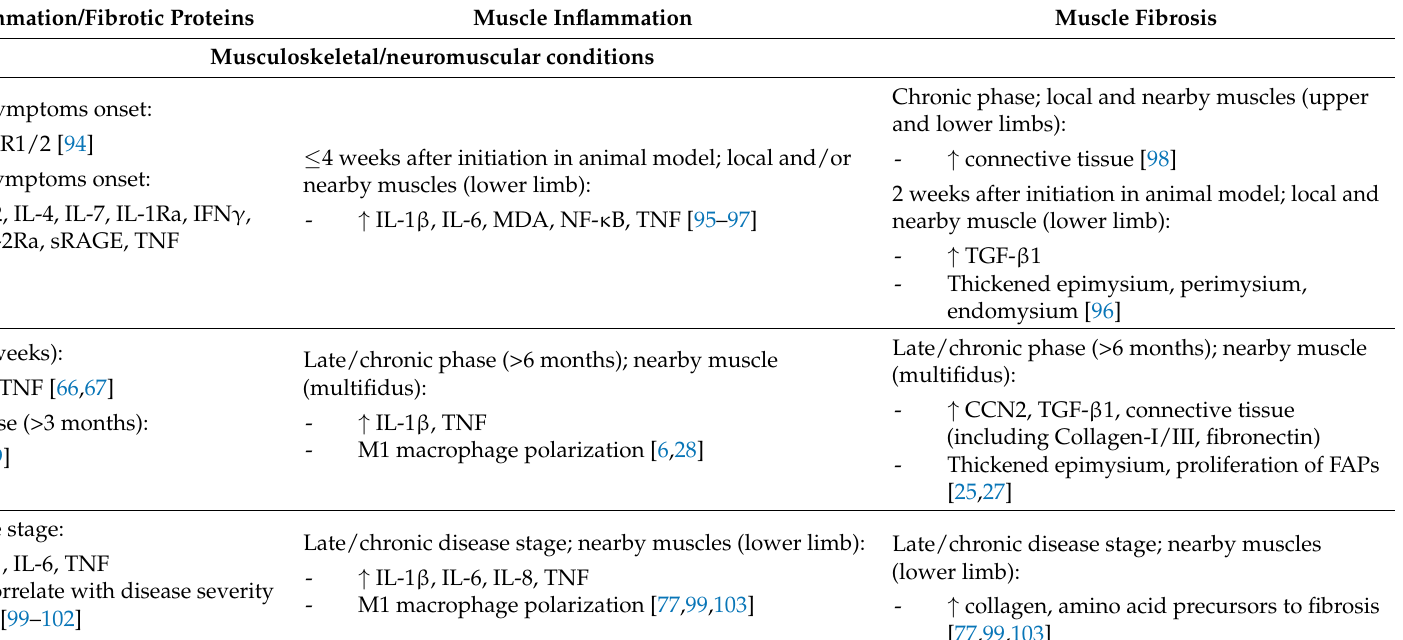
Table 1. Examples of musculoskeletal and chronic metabolic/lifestyle-related conditions characterized by inflammation and fibrosis at both the systemic and muscle levels.